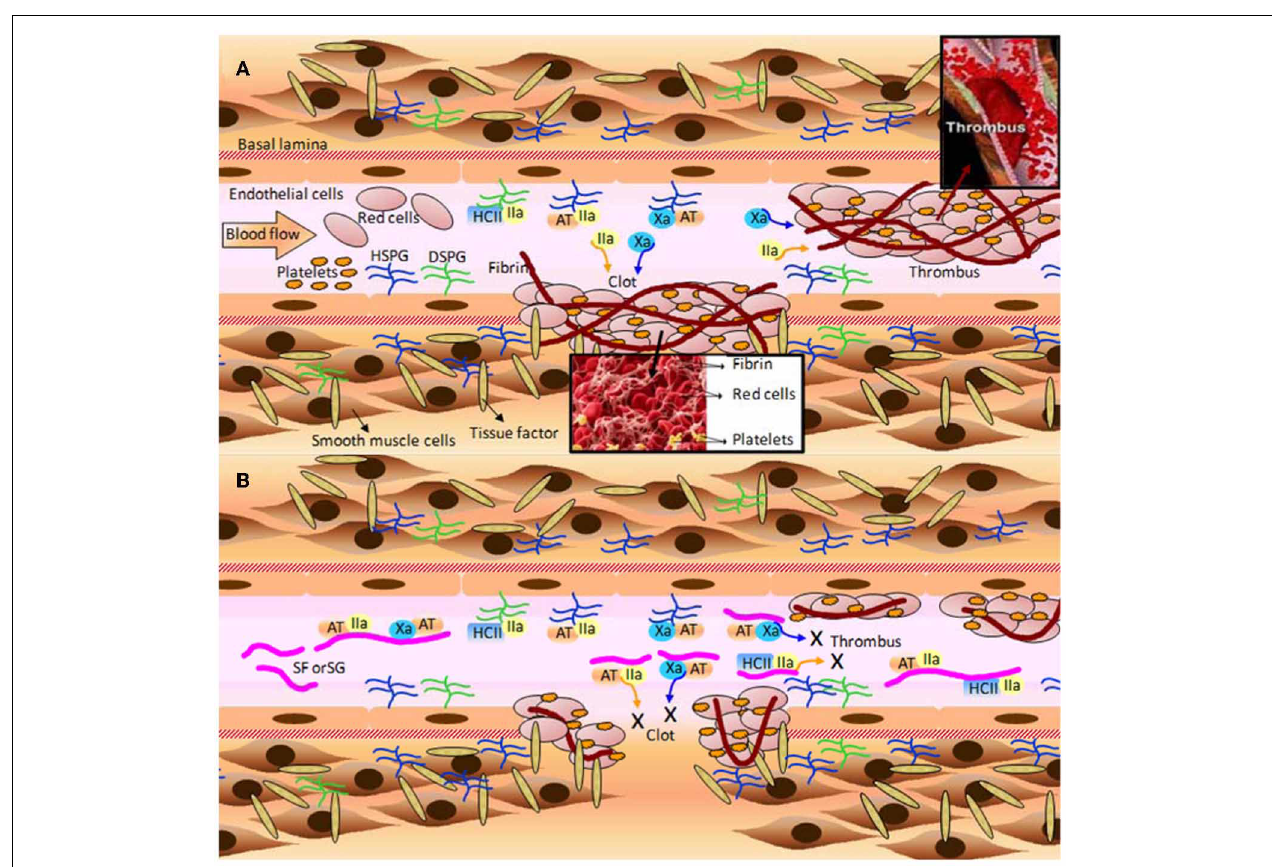
FIGURE 4 | A few of the molecular and cellular players in (A) blood coagulation, clot and thrombus formation; and (B) the anticoagulant and antithrombotic mechanisms of the marine sulfated fucans (SFs) and sulfated galactans (SGs). (A) When the blood vessel wall is disrupted by an injury (atherosclerotic plaque or a physical rupture, for example) tissue factors normally expressed and localized below the basal lamina become exposed to the blood stream. Blood factor XII is recognized by tissue factor, and after making complex with it, becomes factor XII activated (XIIa) (complex not shown). XIIa initiates the blood coagulation cascade leading to the expressive formation of thrombin (IIa) and factor X activated (Xa). These factors feed the formation of more blood coagulation factors which will result in clot or thrombus formation. Thrombin acts directly on fibrinogen in order to form fibrin fibers, which stabilizes the clots and thrombus through cross-linked fibers. Platelets play an important role to this stabilization as well. The natural inhibitors of the two proteases (Xa and IIa) are the serpins antithrombin (AT), and heparin cofactor II (HCII). AT is able to act directly on either Xa or IIa, whereas HCII acts only on IIa. Upon interaction with heparan sulfates and